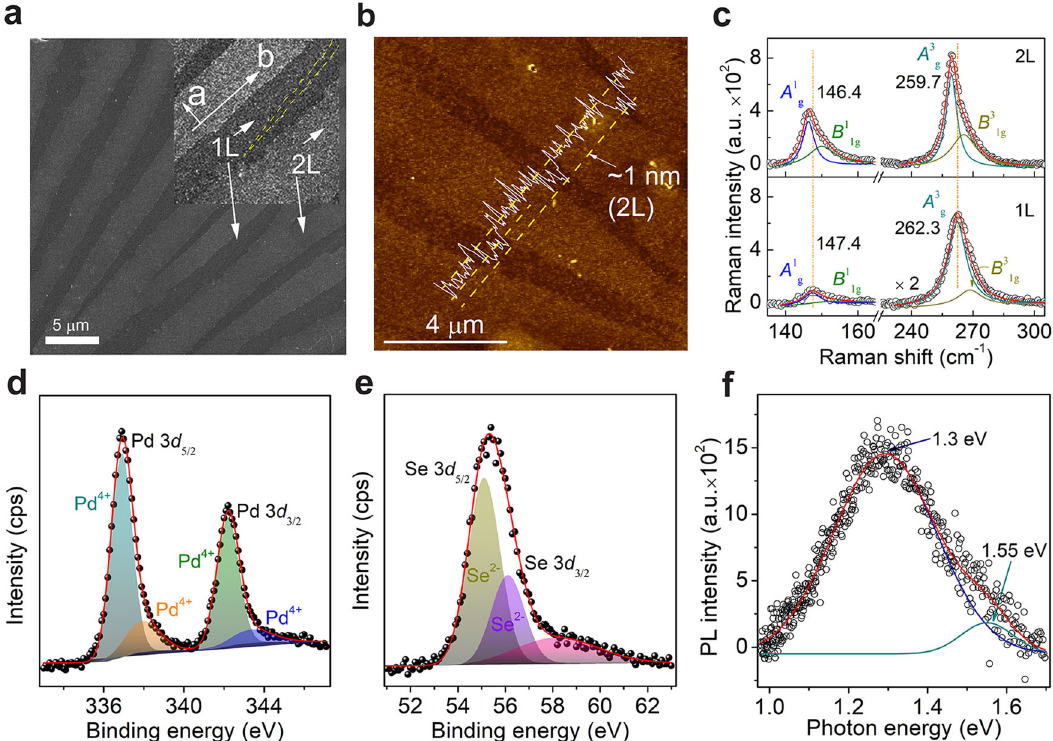
Fig. 1 Morphology, composition and optical properties of dendritic 2D PdSe 2 . a FESEM image of 1L and 2L PdSe 2 . The inset depicts the magni fi ed view with dendrite propagation direction (along a axis and b axis). b AFM image with height pro fi le of 2L (~1 nm), 1 L (~0.5 nm) PdSe 2 , respectively. c Stacked Raman spectra with Lorentzian fi t for 1L and 2L PdSe 2 , where symbols represent raw data and solid lines show fi tted spectra. f NIR photoluminosence fi tted spectra. d , e XPS spectra of PdSe 2 dendrites for ( d ) Pd 3d and ( e ) Se 3d, with shirley baseline spectrum of PdSe 2 dendrites with Gaussian fi